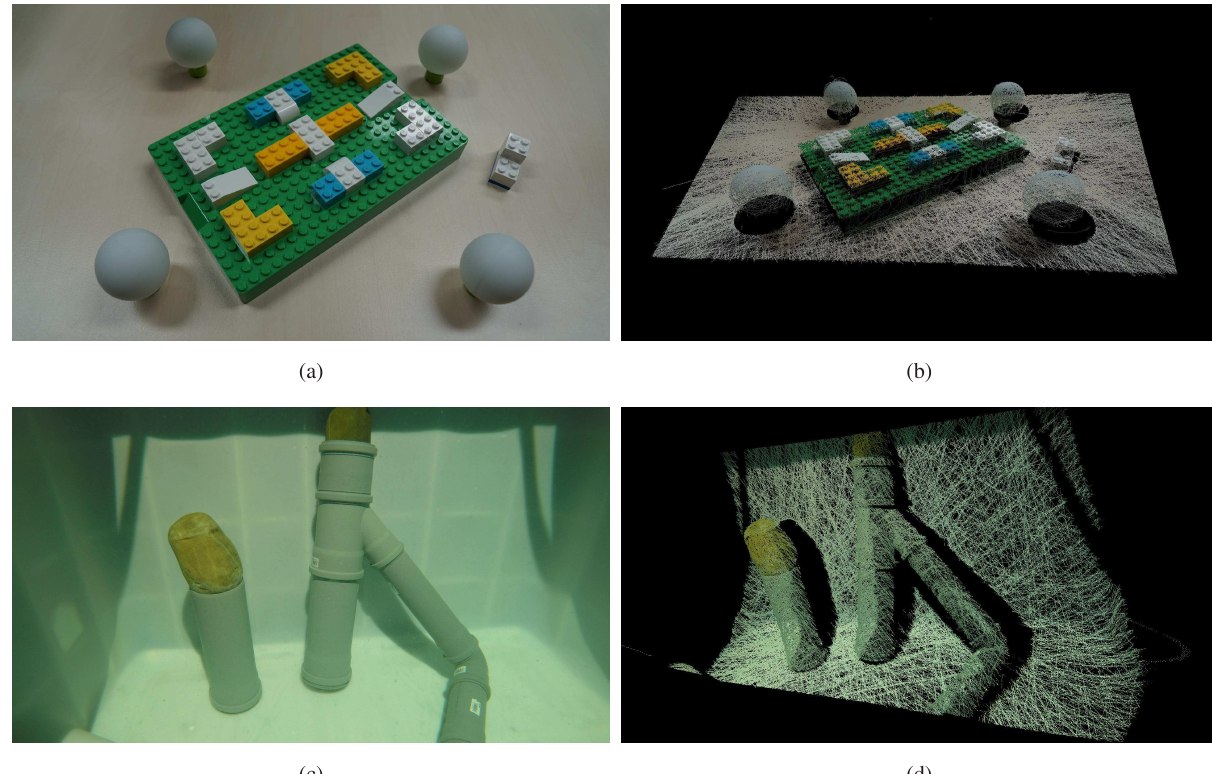
Figure 5: Test scenes and examples of 3D point clouds created using the proposed method.